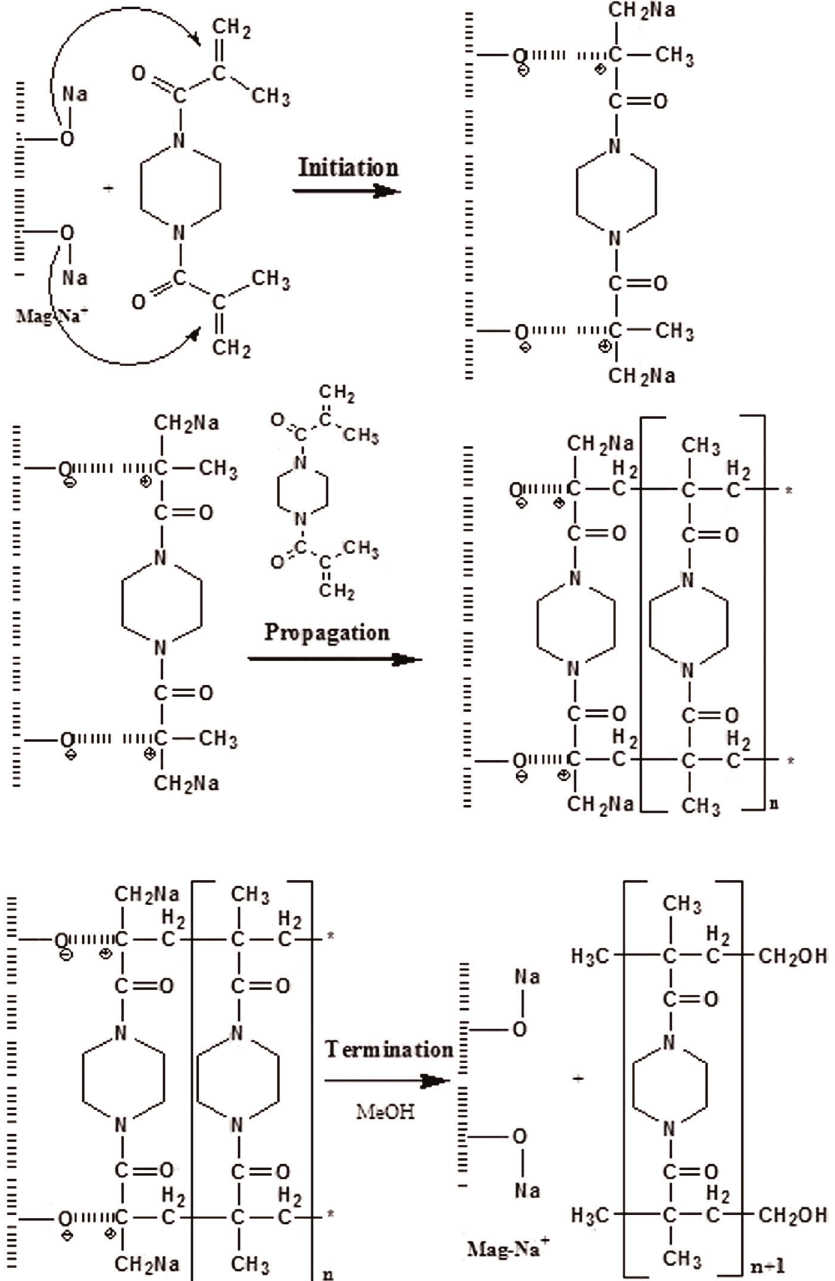
Figure 12: Proposed reaction mechanism of NBMP